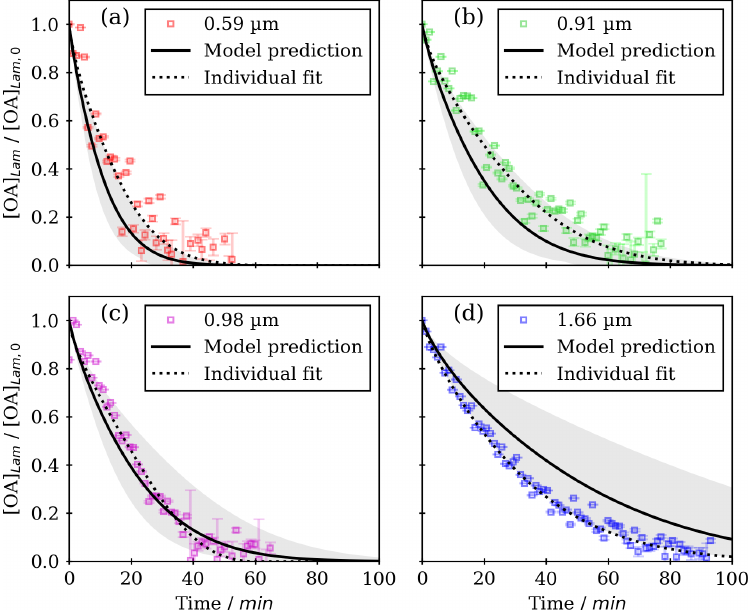
Figure 2. Kinetic decay plots of normalised lamellar-phase oleic acid concentration ( [ OA ] Lam / [ OA ] Lam , 0 ) as a function of time (experi- mental data from Milsom et al., 2021b); model predictions are based on the optimised model parameters determined by fitting all the data simultaneously. Individual fits to each dataset are also presented. Film thicknesses are displayed in each legend. The grey-shaded regions represent the range of model outputs using parameter sets optimised from each individual fit. Table 2. Optimised diffusion parameters allowed to vary during model optimisation. The full set of model parameters is available in Sect. S2 in the